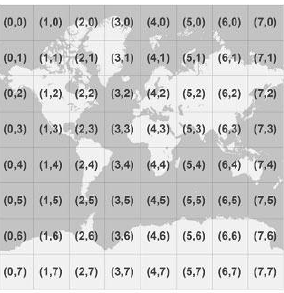
Figure 11. A square covers the whole working area in Web Mercator